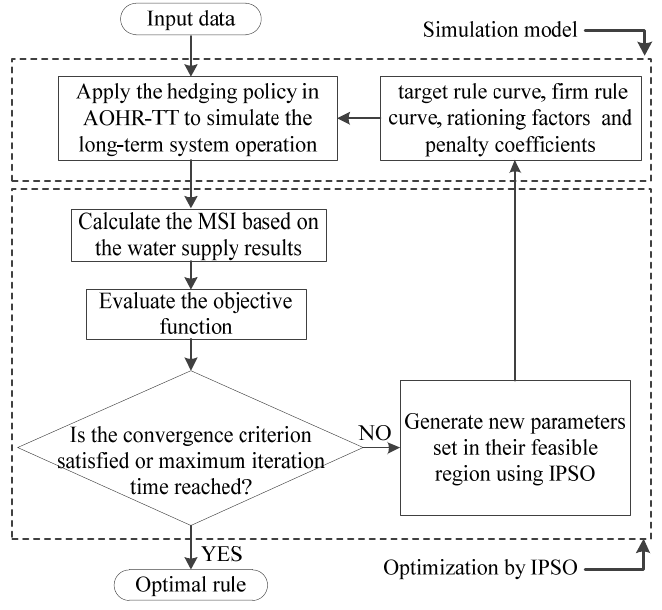
Figure 6. Framework of the optimization-simulation model used to determine the optimal rule.